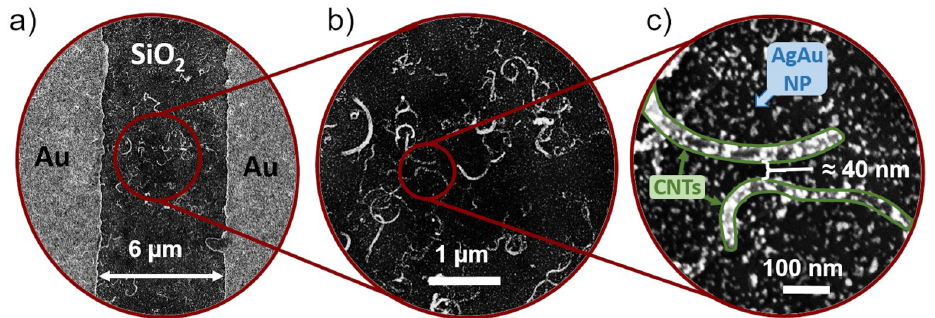
Fig 3. SEM micrographs of a finished [CNT/AgAu network] without SiN layer. a+b) Homogeneous sparse CNT network between the electrodes. c) A nanogap between two CNTs with deposited AgAu NP. The samples shown in the images have not been coated with